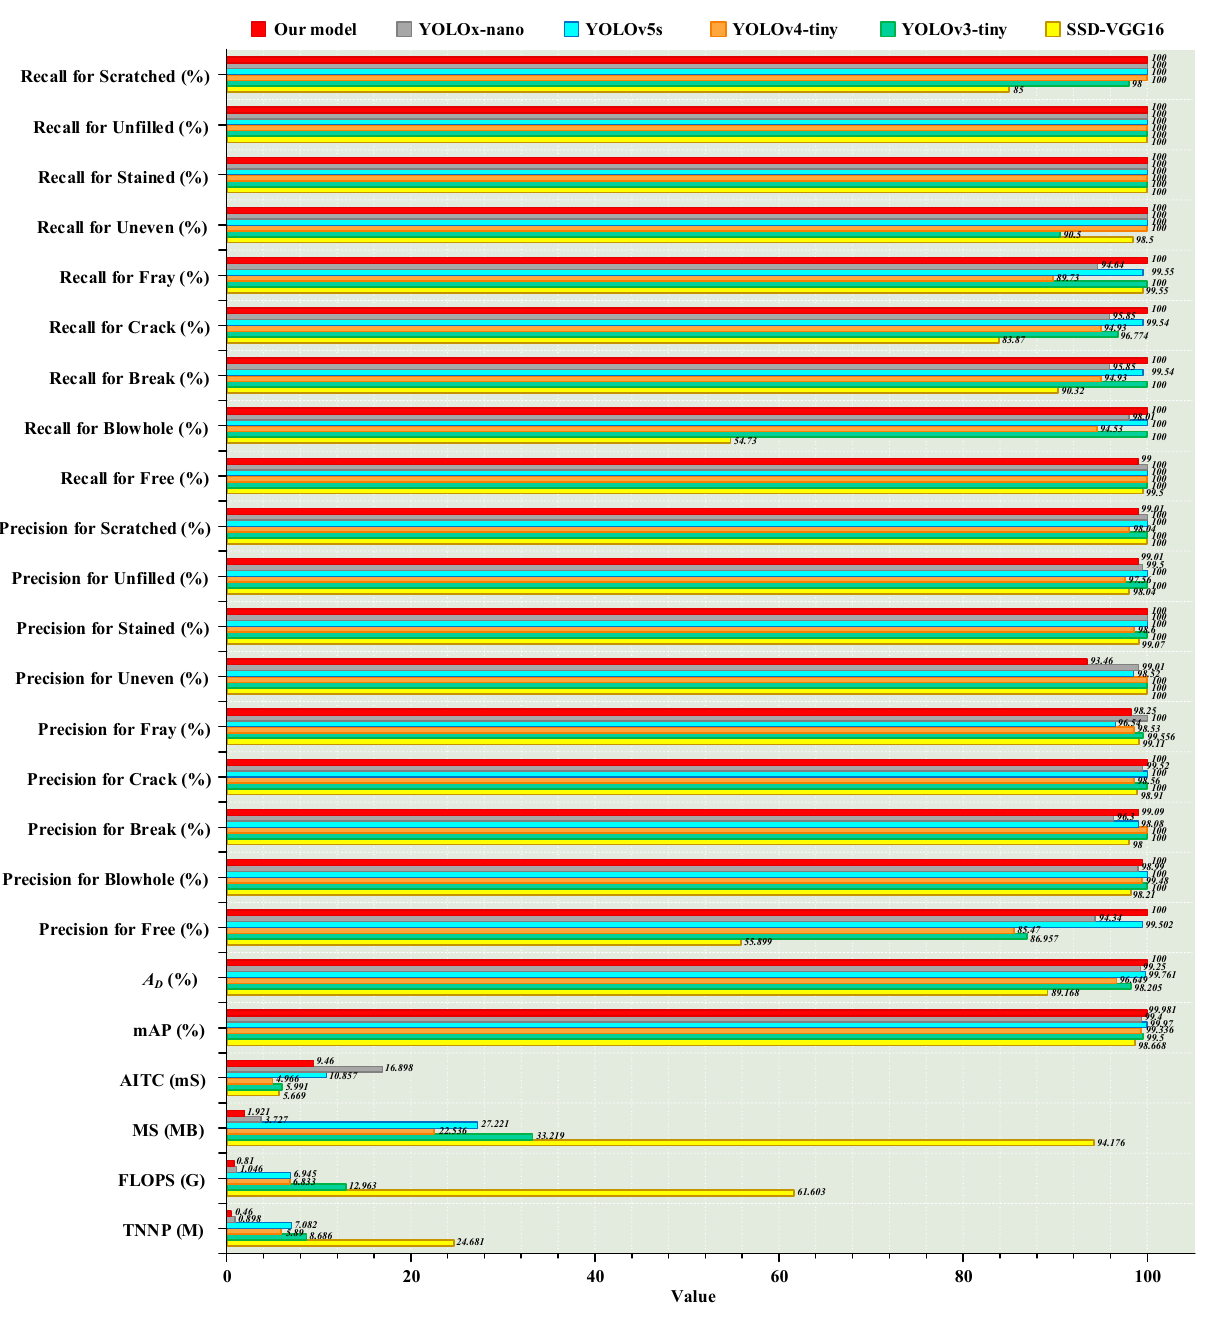
Figure 9. Performance of different models for identifying surface defects. Table 3. Performance comparison of the proposed model and original YOLOv5s in the image-based insulator defect